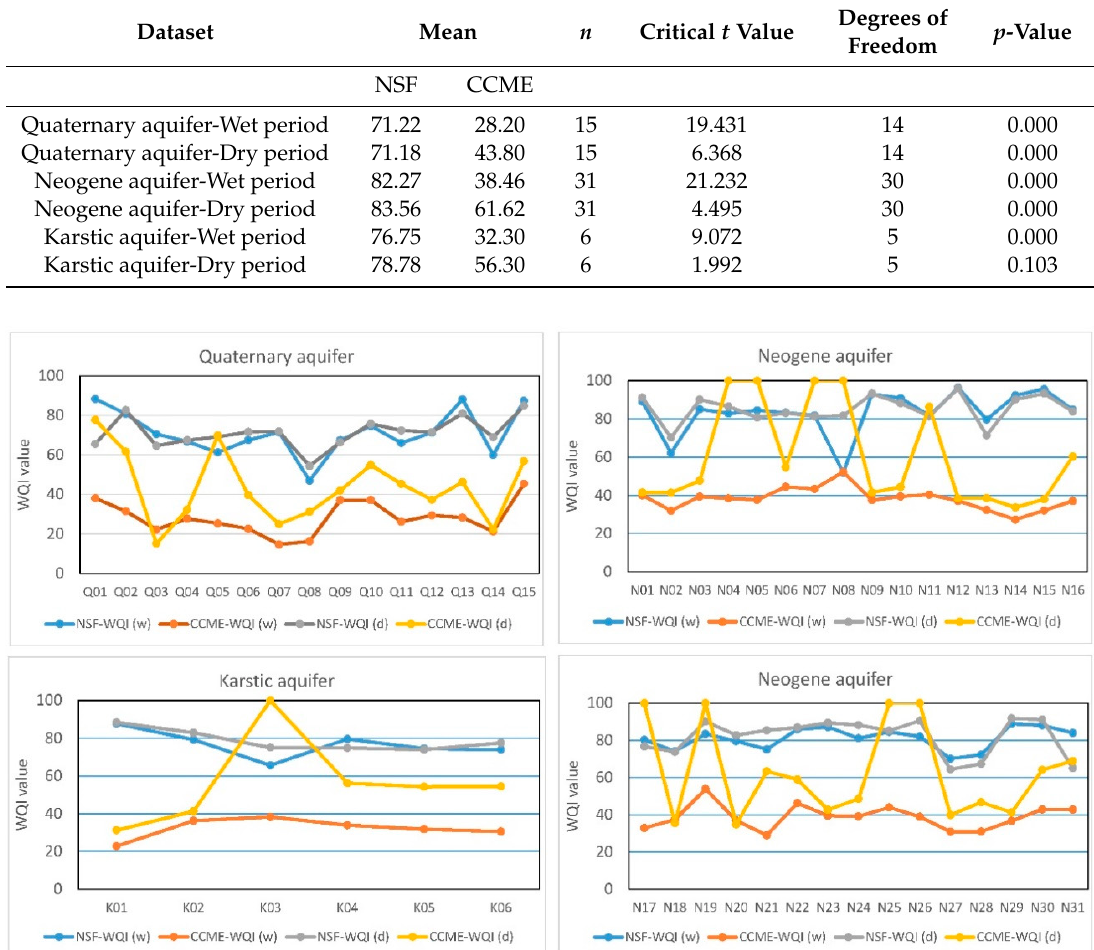
Table 3. Results of student t -test applied for the WQI values of the area studied.